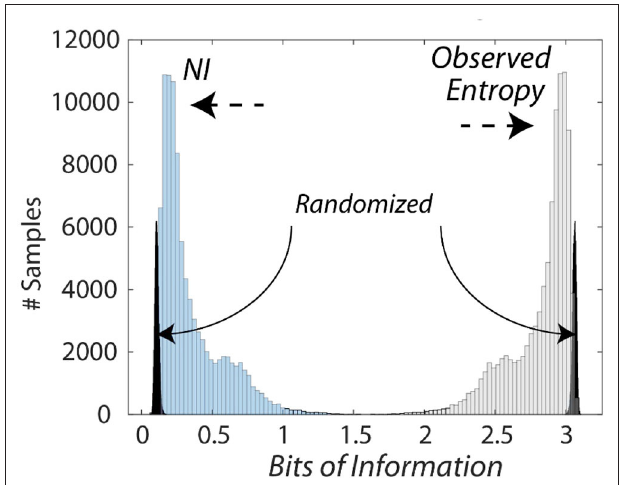
FIGURE 3 | Histogram of the information levels in a medical flight team. This figure shows the relationship between the entropy and the NI measures of the medical flight team detailed in Figure 8 . The average NI was 0.27 bits while the NI where the NDS were randomized prior to modeling was 0.09 bits which was significantly lower than the non-randomized data ( Z = − 5.5 P < 0.001), and removed the long-tailed